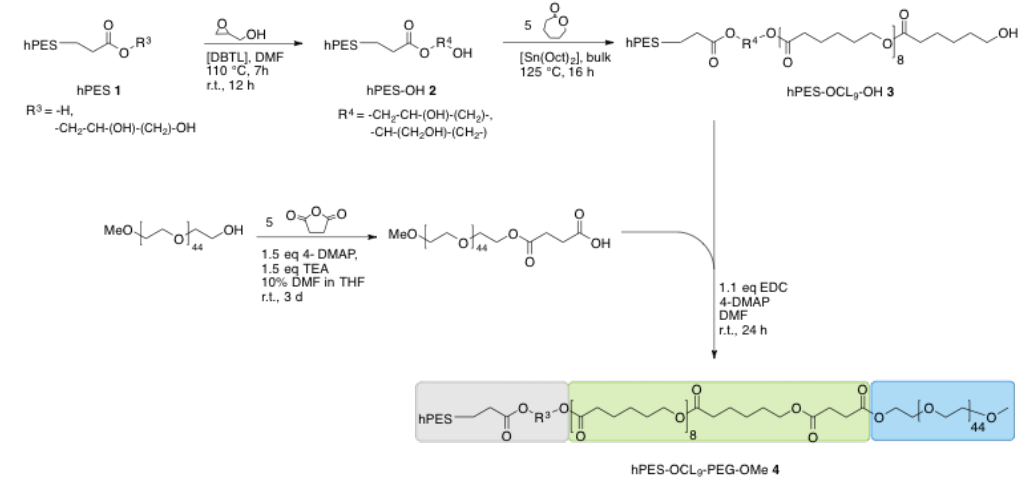
Table 1 . Comparison of physical characteristics of CMS with its macroinitiator and